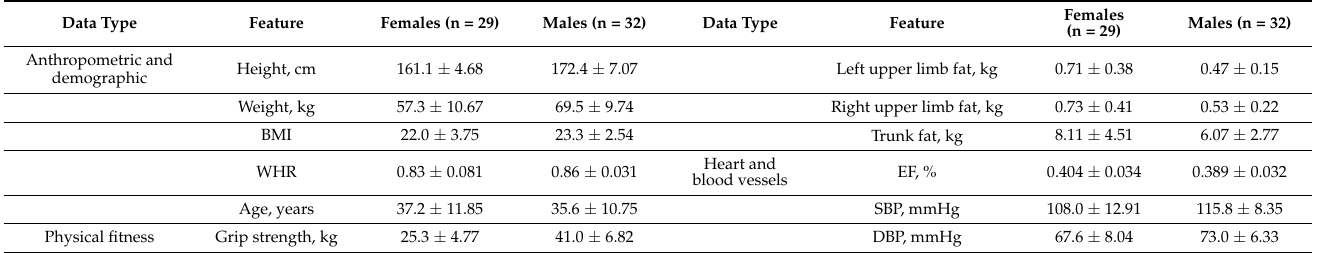
Table 1. Static human body data for the participants according to sex. Values refer to mean ± standard deviation